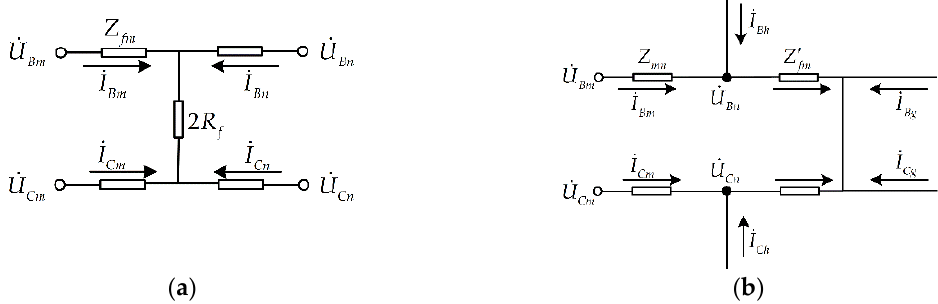
Figure 5. Circuit diagrams of phase B-to-phase C faults: ( a ) A non-bolted fault happens at f1; ( b ) A bolted fault happens at f2.